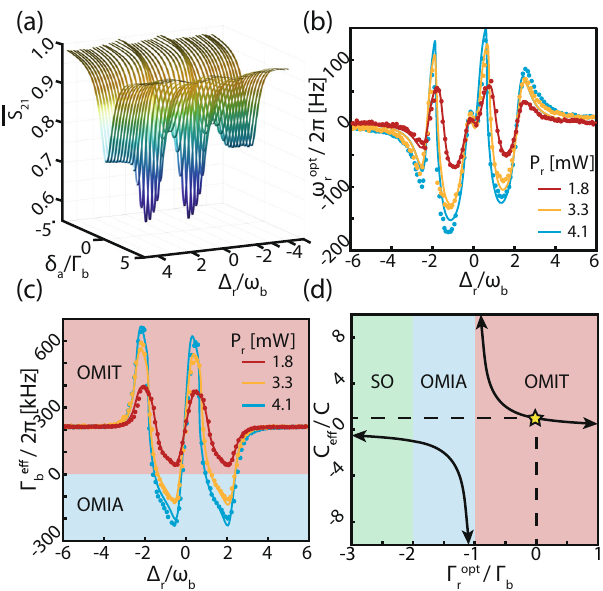
Fig. 2 Tuning the mechanical resonator dynamics. a Normalized OMIT scans as a function of mode a probe-cavity detuning, δ a , and control- reservoir detuning, Δ r , and S 21 is the probe laser re fl ection measured using a vector network analyzer. The changes in the transparency window as a function of Δ r are indicative of reservoir interactions. Optomechanically manipulated effective ( b ) mechanical frequency and ( c ) damping as a function of Δ r and the reservoir-mode input power, P r . ( d ) Illustration of effective cooperativity, C eff , for varying Γ eff controlled by the reservoir b ¼ Γ a control fi eld. mode, when Γ opt b due to the presence of the mode a Three different regimes of operation are shown: OMIT OMIA, and self- oscillation (SO). The yellow star indicates the operating point when the reservoir fi eld is